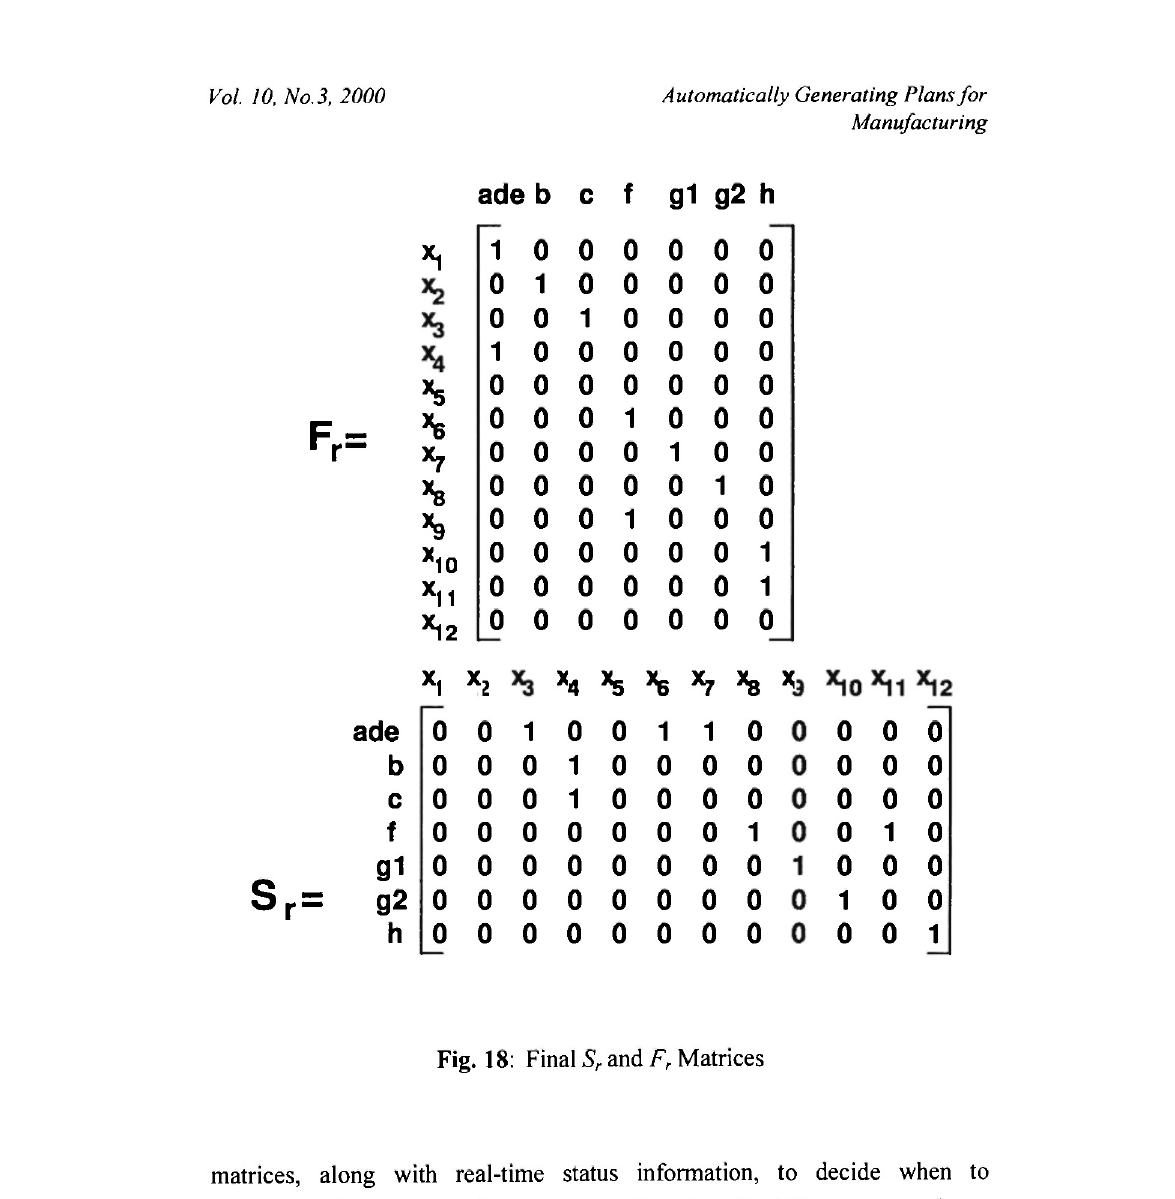
Fig. 18: Final S r and F r